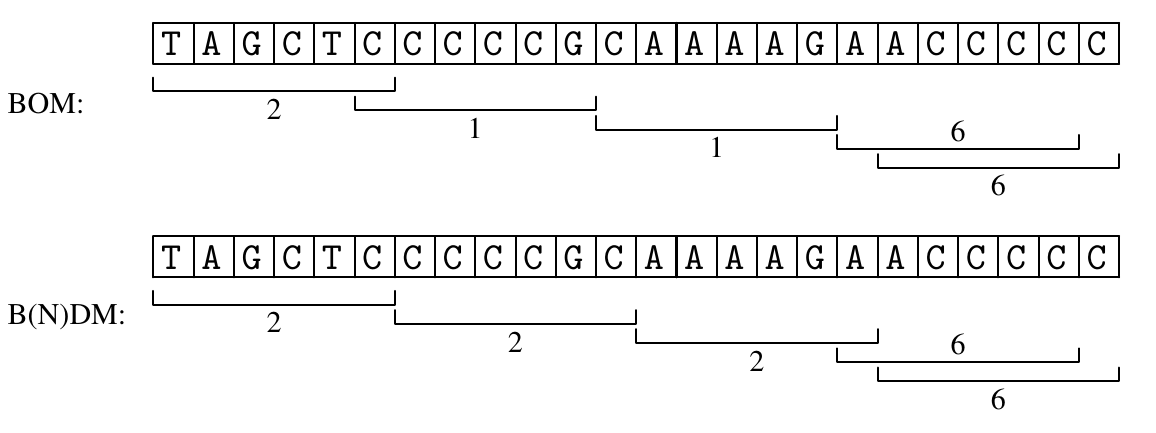
Figure 5. Example of a string for which BOM executes less character accesses than B(N)DM when searching for the pattern p = ACCCCC . The searched windows are indicated below the text; the nearby number gives the number of character accesses executed when processing this